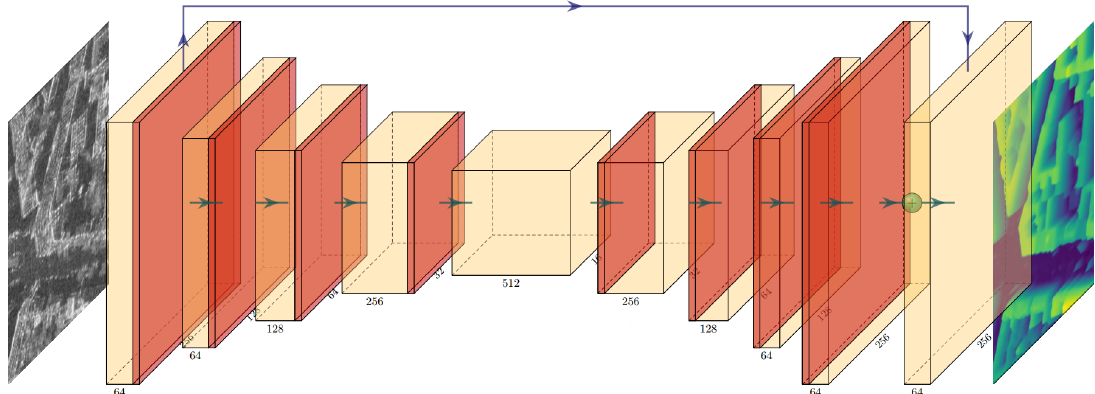
Figure 2. CNN architecture based on the IM2HEIGHT model (Mou and Zhu, 2018). In the left half of the network, the incoming image data is successively transformed into increasingly abstract representations using learned convolution kernels. In the right half, the center-resulting “representation cube” is again unfolded into an image-based representation, with the desired result in this case being a height image. The connecting arrow shown above between the first and the last layer of the network represents a so-called skip connection, which allows the spatial structures still present in the image at full resolution to be transferred to the resulting image. Table 2. Quantitative evaluation results calculated for predictions on the hold-out test